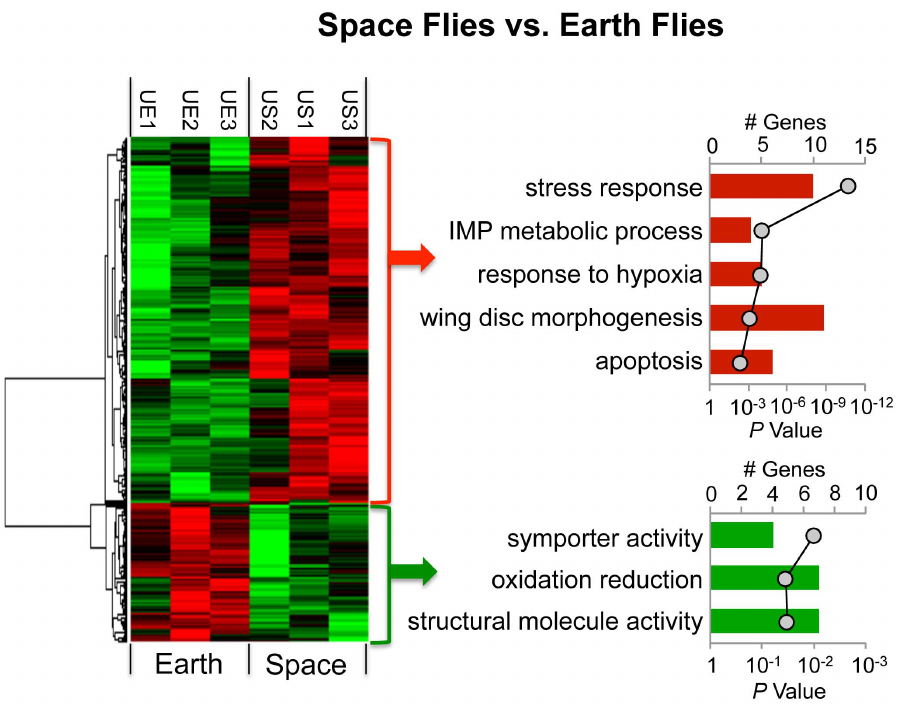
Figure 6. Analysis of transcriptional modulations produced by spaceflight. Transcriptional profiles of uninfected space and Earth flies were compared and differentially expressed genes were grouped by hierarchical clustering. Pathway analysis was utilized to identify statistically enriched biological themes. The number of genes in each category is depicted in bar graphs (primary y-axis), and the P values corresponding to statistical over- representation of each category are presented as a line graph (secondary y-axis).